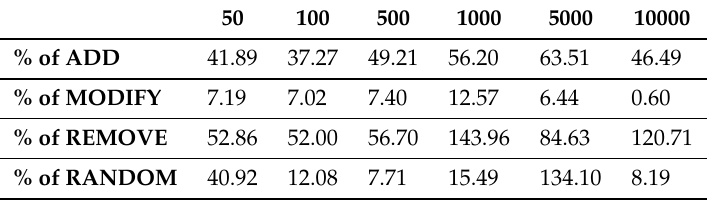
Table 6. The difference between the minimum (remove) and maximum (insert) execution times.